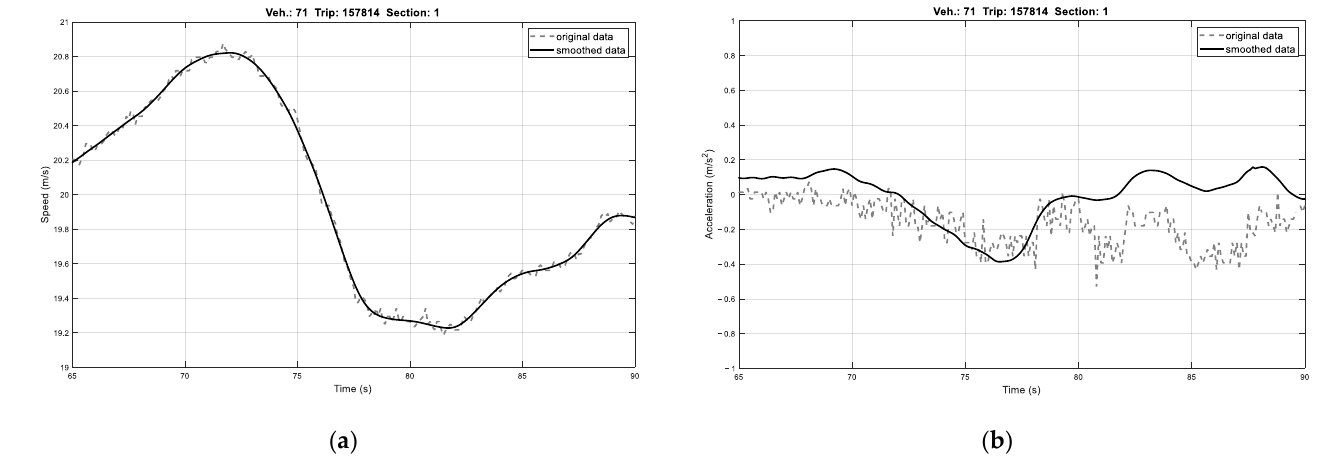
Figure 3. Example of pre-processed driving data: ( a ) speed; ( b ) acceleration.